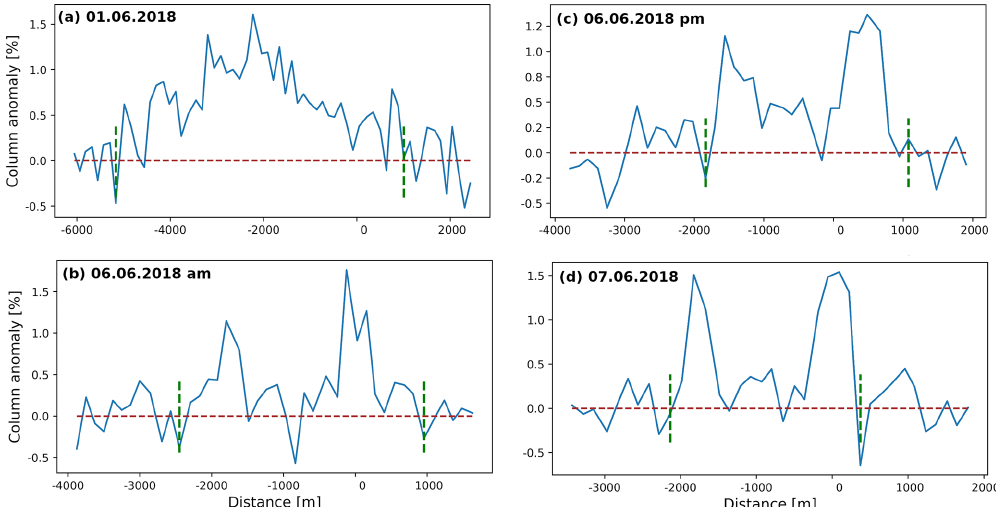
Figure C5. Same as Fig. C1 but for shaft cluster c. A 2D visualization is shown in Fig. C4.